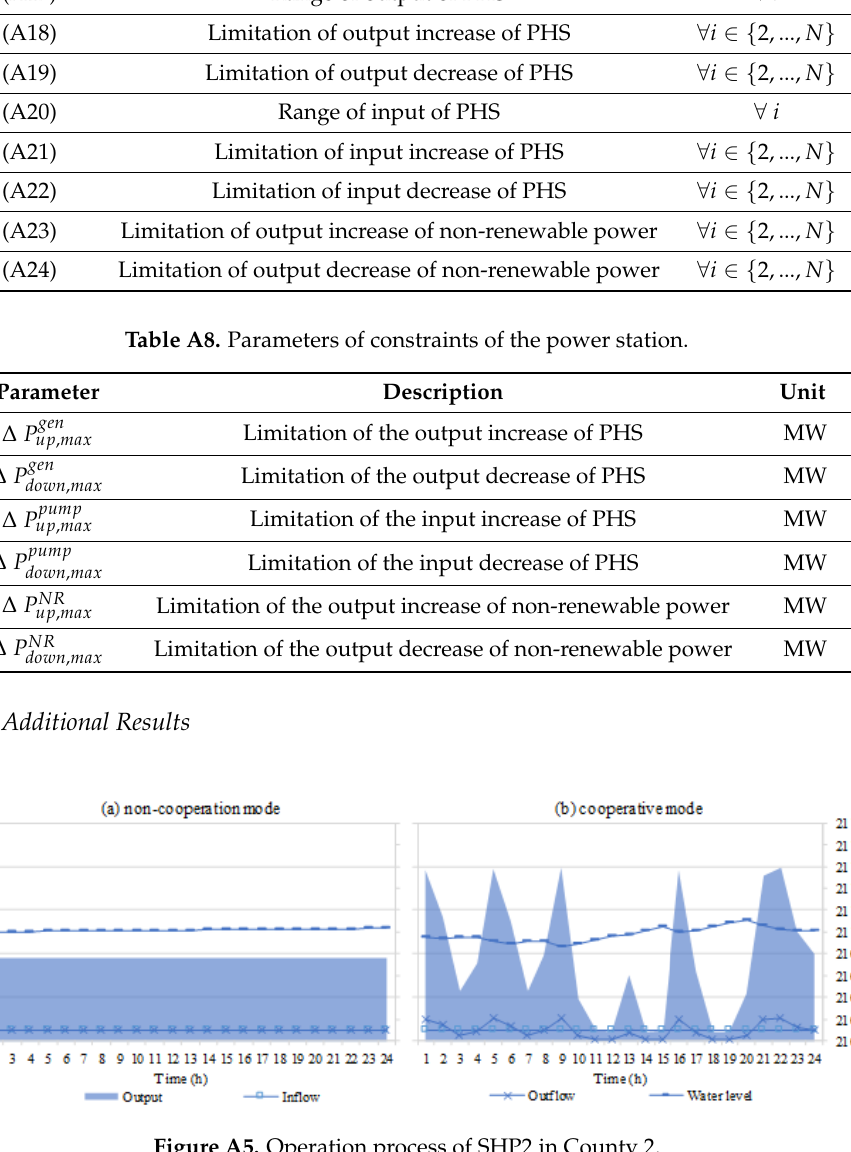
Figure A5. Operation process of SHP2 in County